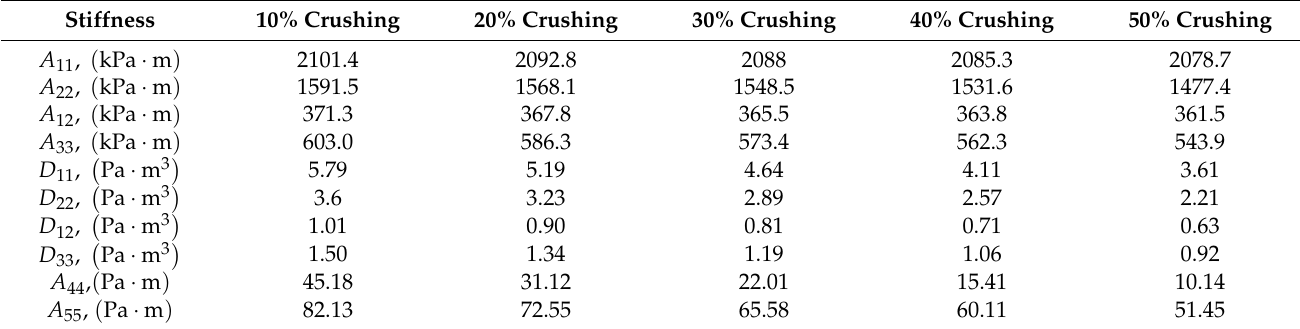
Table 6. The stiffnesses of the representative shell element computed for different crushing of corrugated cardboard sample for local deterioration scaling factors, separately for region A and region B. Stiffness